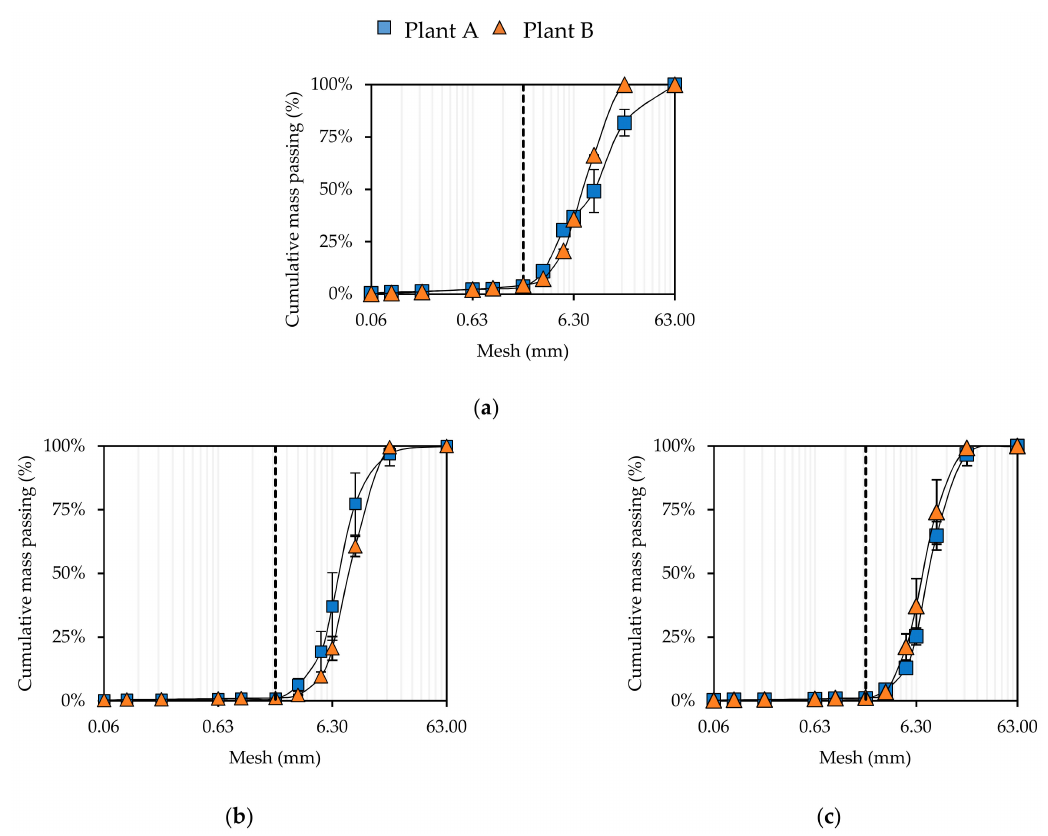
Figure 3. Particle size distribution of ( a ) the raw samples from Plant A and Plant B, of ( b ) samples treated for 60 min and of ( c ) samples treated for 120 min. Dotted line is mesh = 2